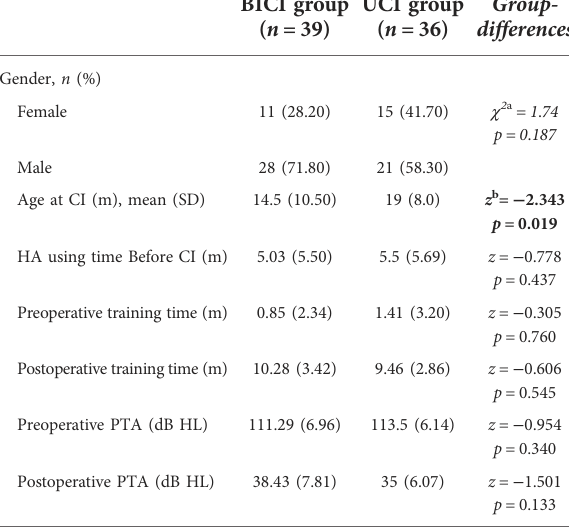
TABLE 1 Patient demographics and audiological